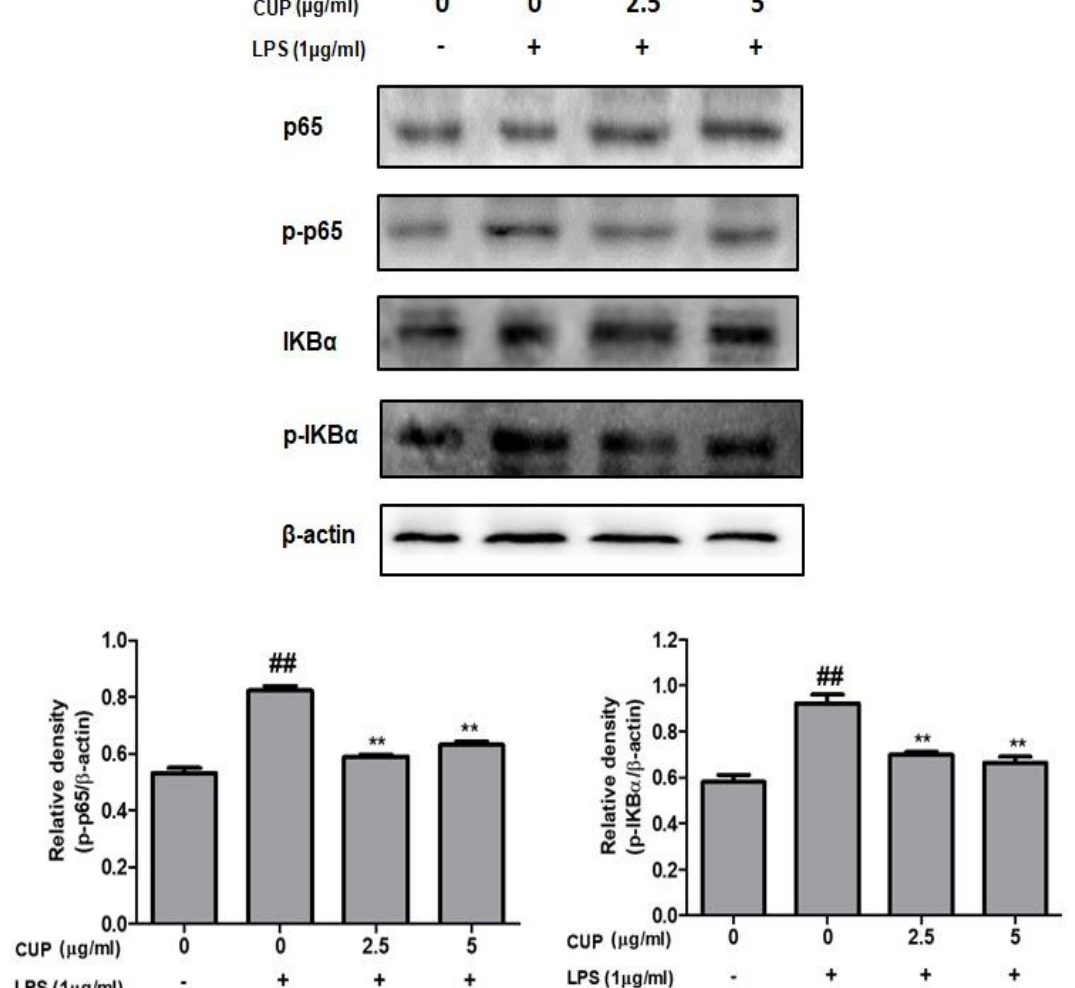
Figure 6. Effect of Citrus unshiu peel (CUP) flavonoids on LPS-stimulated p-p65, p65, p-I κ B α , and I κ B α protein levels in RAW264.7 cells. Cells treated with different concentrations of CUP flavonoids (0, 2.5, and 5 µ g/mL) for 24 h, with or without 1 h pre-incubation of lipopolysaccharide (LPS) (1 µ g/mL). Relative expression of p-p65/p65, and p-I κ B α /I κ B α was measured and β -actin was used as internal control. Bands expressed in Western blots were measured by densitometry. Note: Data are the mean ± SEM of experiments in triplicate (n = 3). ## p < 0.01 vs. untreated group; ** p < 0.01 vs. LPS-alone treated